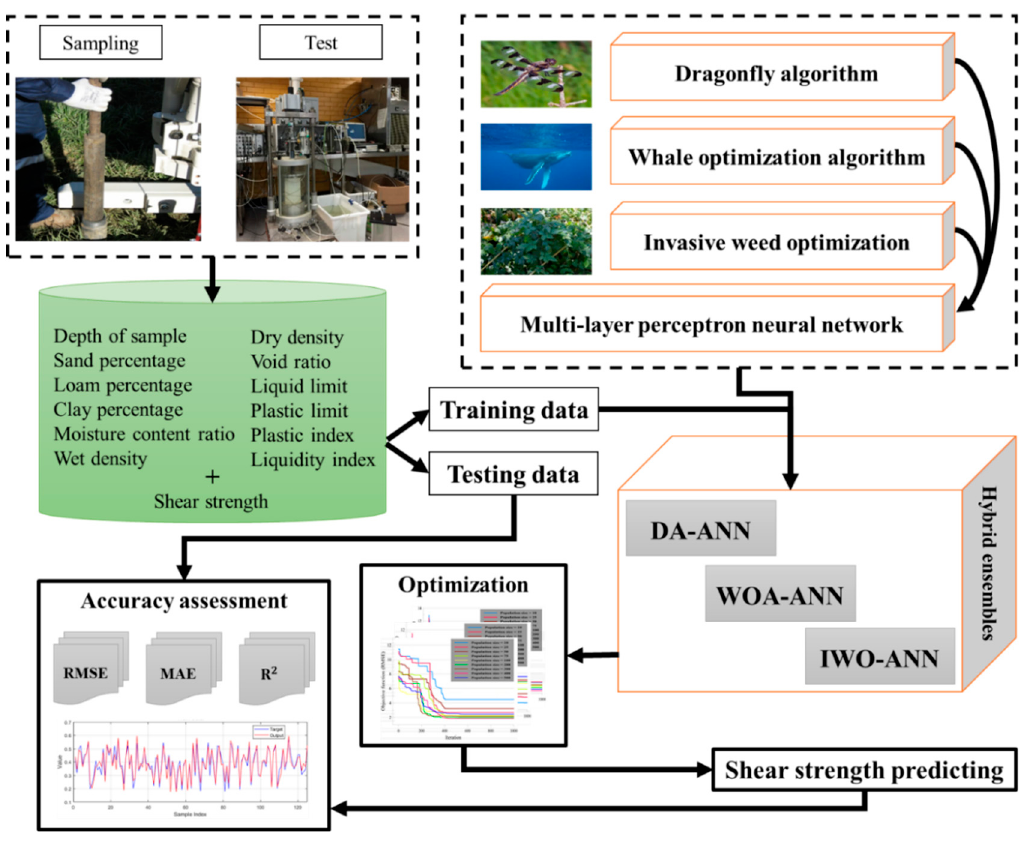
Figure 1. The steps taken to predict the shear strength in this study.